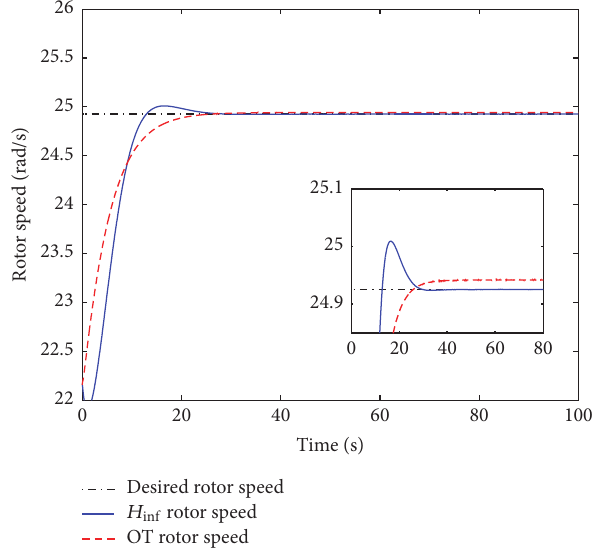
Figure 2: Rotor speed constant tracking.